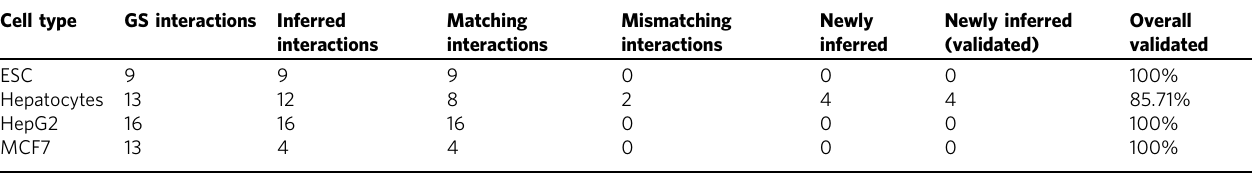
Table 1 Benchmarking reconstructed core GRNs against experimentally validated core